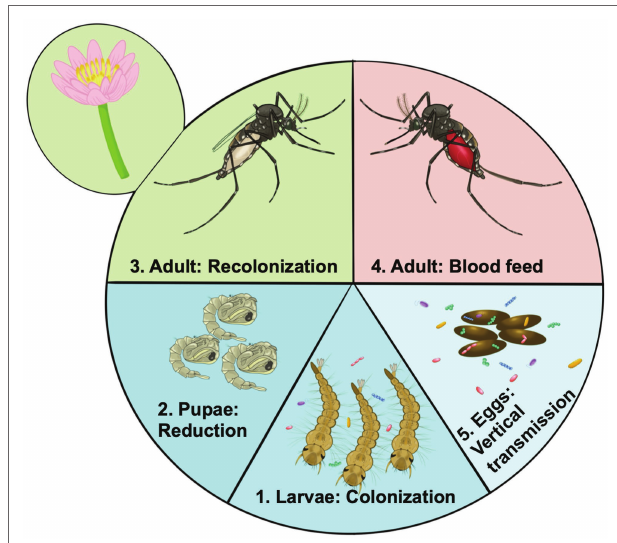
FIGURE 2 | Acquisition and transmission of the microbiome over the life cycle of the mosquito. 1. Microorganisms from the aquatic environment colonize the larvae. These organisms provide essential nutrients such as B vitamins. 2. During pupation there is a large reduction for or even elimination of the microbiome. 3. After emergence mosquitoes are exposed to rearing water potentially being recolonized by aquatic bacteria, but are also exposed to new sources of colonizing bacteria such as flower nectar. 4. Certain members of the microbiome may facilitate blood digestion by female mosquitoes becoming more abundant in the gut. Other bacteria may be adapted to survive the high nutrients and reactive oxygen species. 5. Through colonizing the female ovaries microbes may be deposited on the egg surface, ensuring they are available to colonize newly hatched larvae, there by continuing the colonization